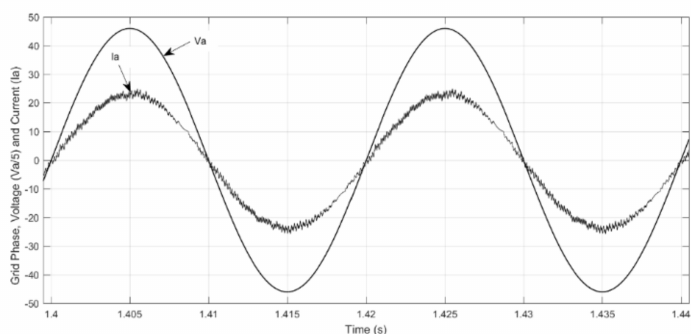
Figure 11. The utility grid voltage and current in phase a.